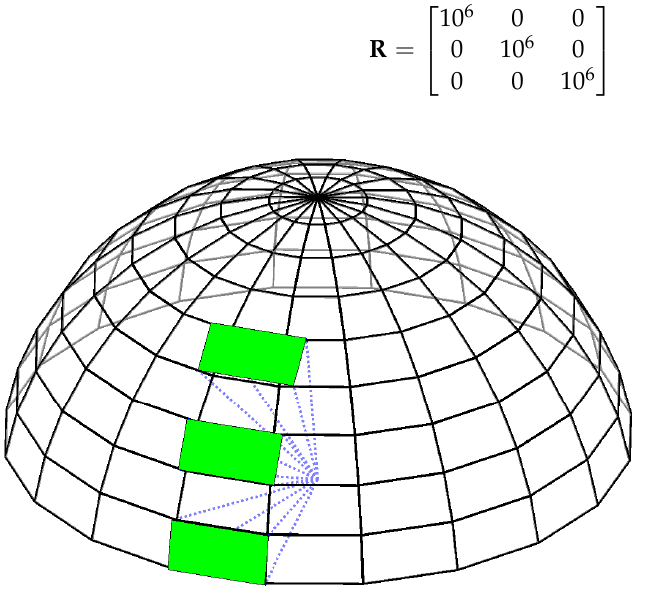
Figure 4. Discretization of the field of regard. The green patches correspond to the regions in the field of regard observed by the sensor at different